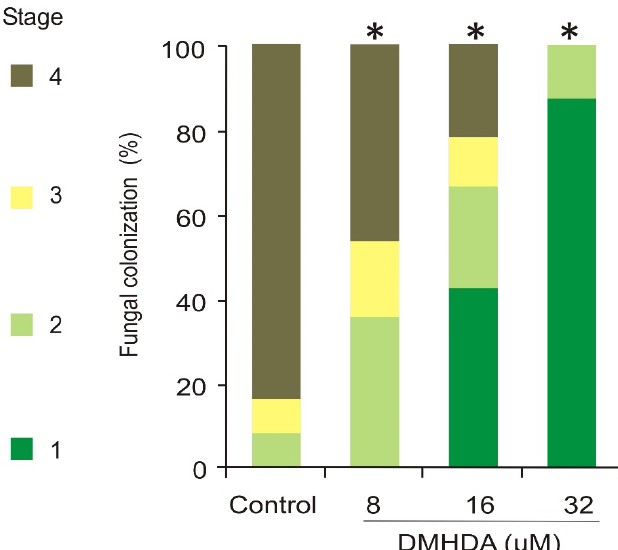
Figure 7. DMHDA induces a long-lasting effect on the immune response of A. thaliana . A. thaliana seedlings were germinated for 72 h with DMHDA (0, 8, 16, 32 µ M) and then transferred to 0.2 × MS DMHDA-free plates; after ten days more, plants were transplanted to substrate mixture and cultured for three weeks before inoculation with 1 × 10 5 conidia/leaf of B. cinerea . Three days after inoculation, 100 leaves of each treatment were stained with trypan blue and classified. Asterisks (*) indicate statistically significant differences in infection stages distribution for each plant treatment (independently) compared to the control (solvent only) condition ( χ 2 test; p < 0.05).